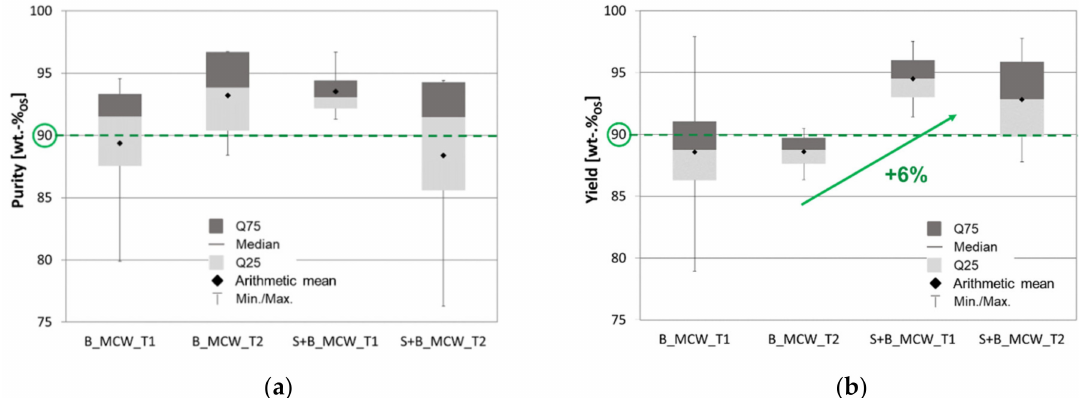
Figure 13. Effects of pre-screening on purity ( a ) and yield ( b ) of the 3D-plastics out of the 3D-fraction from the ballistic separator of the investigated mixed commercial waste